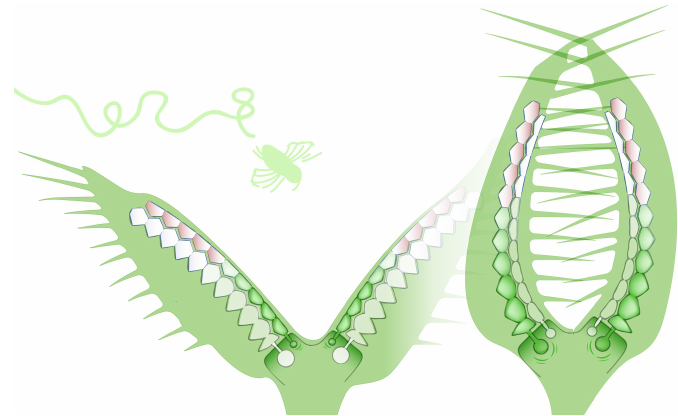
Figure 1. Schematic cell structure of the Venus flytrap. Leaf movement actuated by a change in turgor pressure. Reprinted/adapted by permission from Springer Nature [23].